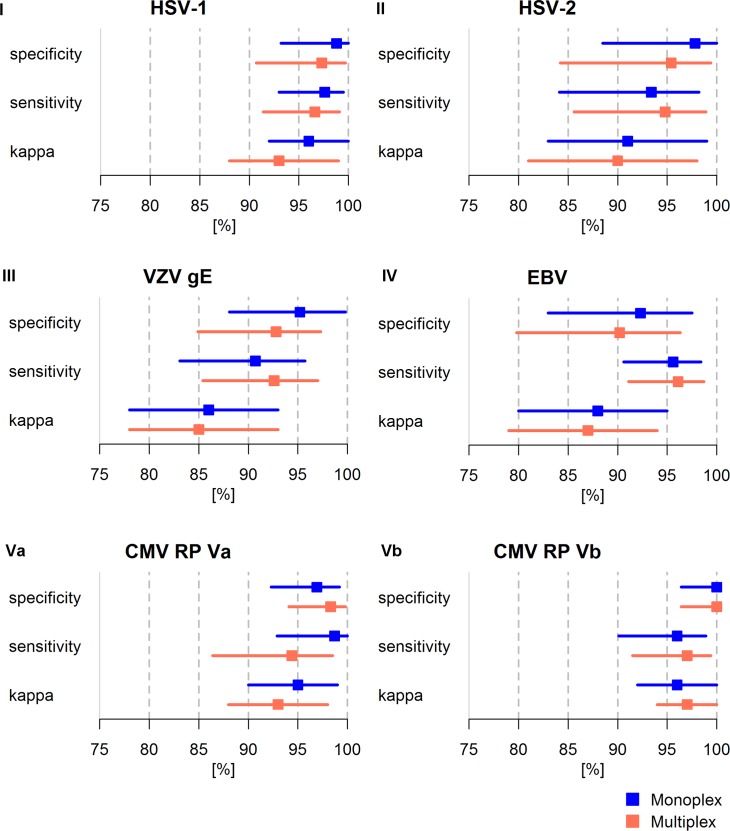
Comparison of statistical performance of HHV species-specific assays in monoplex (blue) and multiplex (orange) format.Performance is shown for overall seropositivity (EBV, CMV) and single antigens for HSV-1 (gG), HSV-2 (mgGu) and VZV (gE). I-Vb indicate corresponding reference panels. Cohen’s kappa statistics are shown in percent to improve visualization. For direct comparison of Monoplex and Multiplex Serology performance on the corresponding reference panel, ICCs were calculated showing good to excellent reliability (ICCHSV1: 0.91 (95% CI 0.88–0.93), ICCHSV2: 0.93 (95% CI 0.89–0.95), ICCVZV: 0.93 (95% CI 0.91–0.95), ICCEBV: 0.87 (95% CI 0.84–0.90), ICCCMV RPVa: 0.82 (95% CI 0.77–0.86), ICCCMV RPVb: 0.99 (95%CI 0.99–1.00)). kappa: Cohen’s kappa. ICC: Intraclass correlation coefficient. CI: confidence interval.